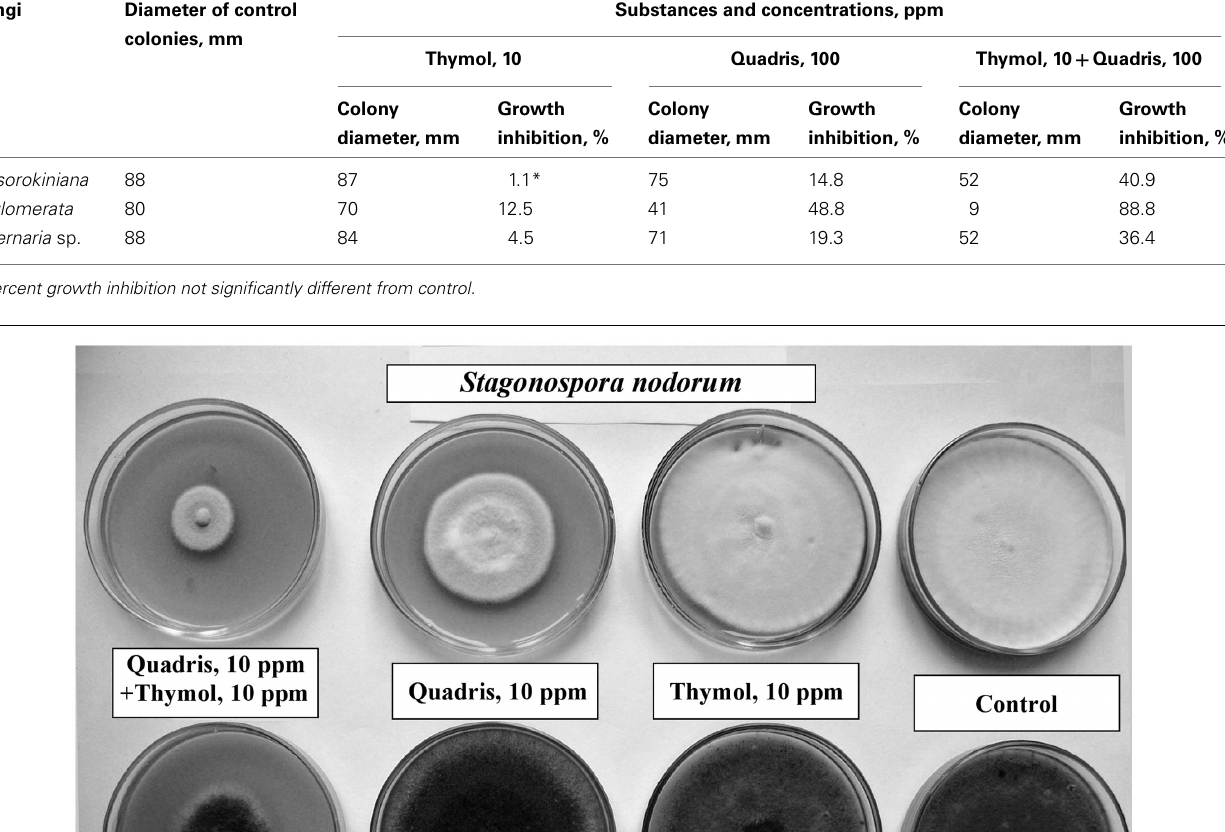
Quadris + thymol, each at 10ppm. Fungi were cultured for 16days. Control colonies were cultured in media with neither thymol nor